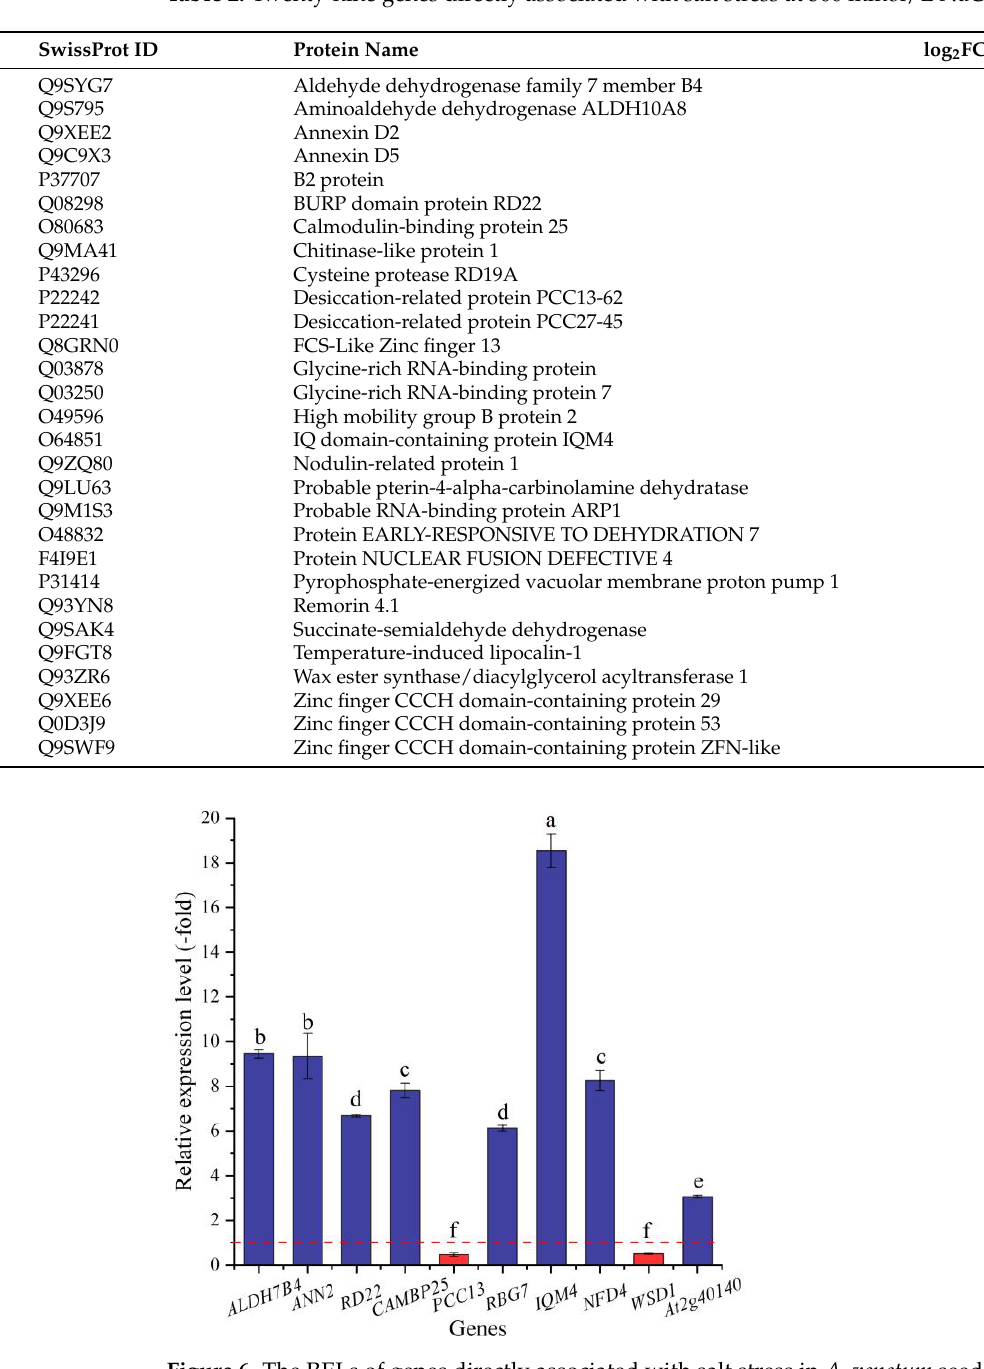
Table 2. Twenty-nine genes directly associated with salt stress at 300 mmol/L NaCl vs. CK.